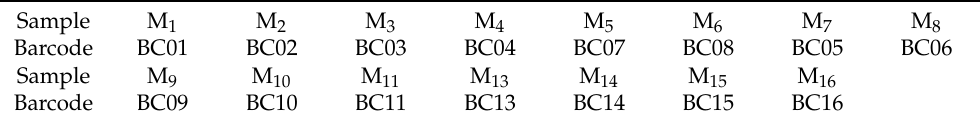
Table 2. The analyzed samples with their corresponding barcodes.